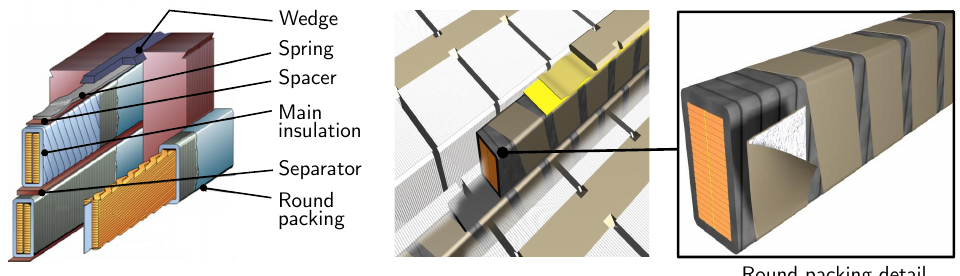
Figure 9. New winding insulation configuration. For reference, the thickness of a stator bar is about 17